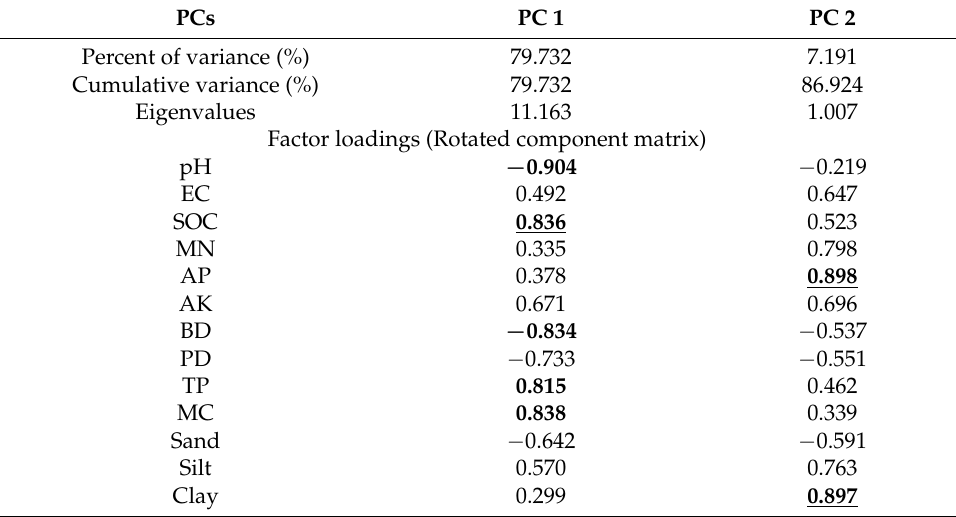
Table 3. Result of principal component analysis (PCA) of significant soil indicators. PCs PC